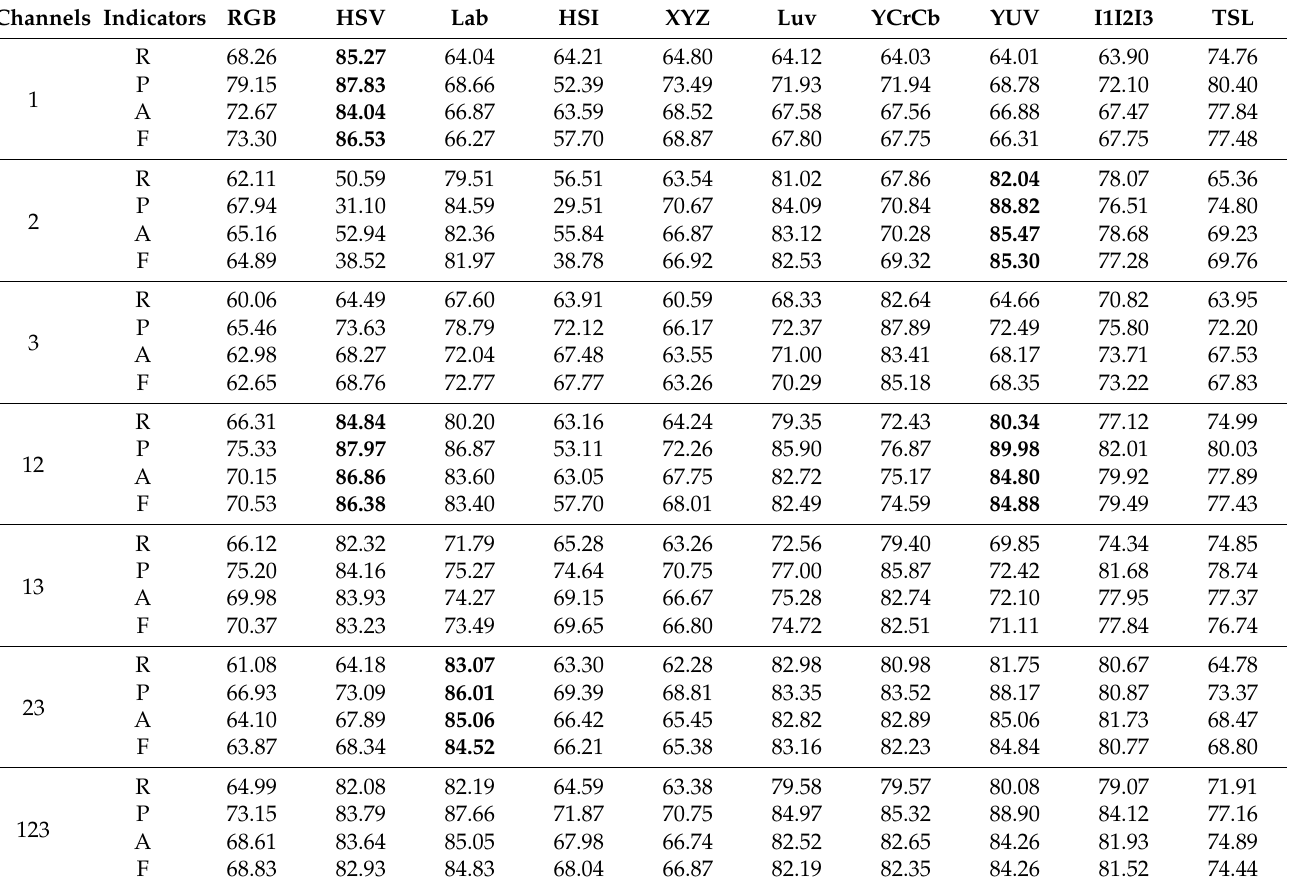
According to the table that the top color channels in index F1 are H (in HSV), HS (in HSV), U (in YUV), CrCb (in YCrCb), YU (in YUV), and Lab in turn; the top color channels in index A are HS (in HSV), U (in YUV), ab (in Lab), Lab, UV (in YUV), and YU (in YUV) in turn; the top color channels in index P are YUV (YUV), U (YUV), UV (YUV), HS (in HSV), CrCb (in YCrCb) in turn and the top color channels in index R, are H (in HSV), HS (in HSV), ab (in Lab), UV (in Luv), Lab, and HSV in turn. According to the evaluation results, HS (in HSV) was selected as the MOCC, H (in HSV) was selected as the FOCC, U (in YUV) was selected as the AOCC, YU (in YUV) was selected as the POCC, and ab (in Lab) was selected as the ROCC, which were marked in bold in the